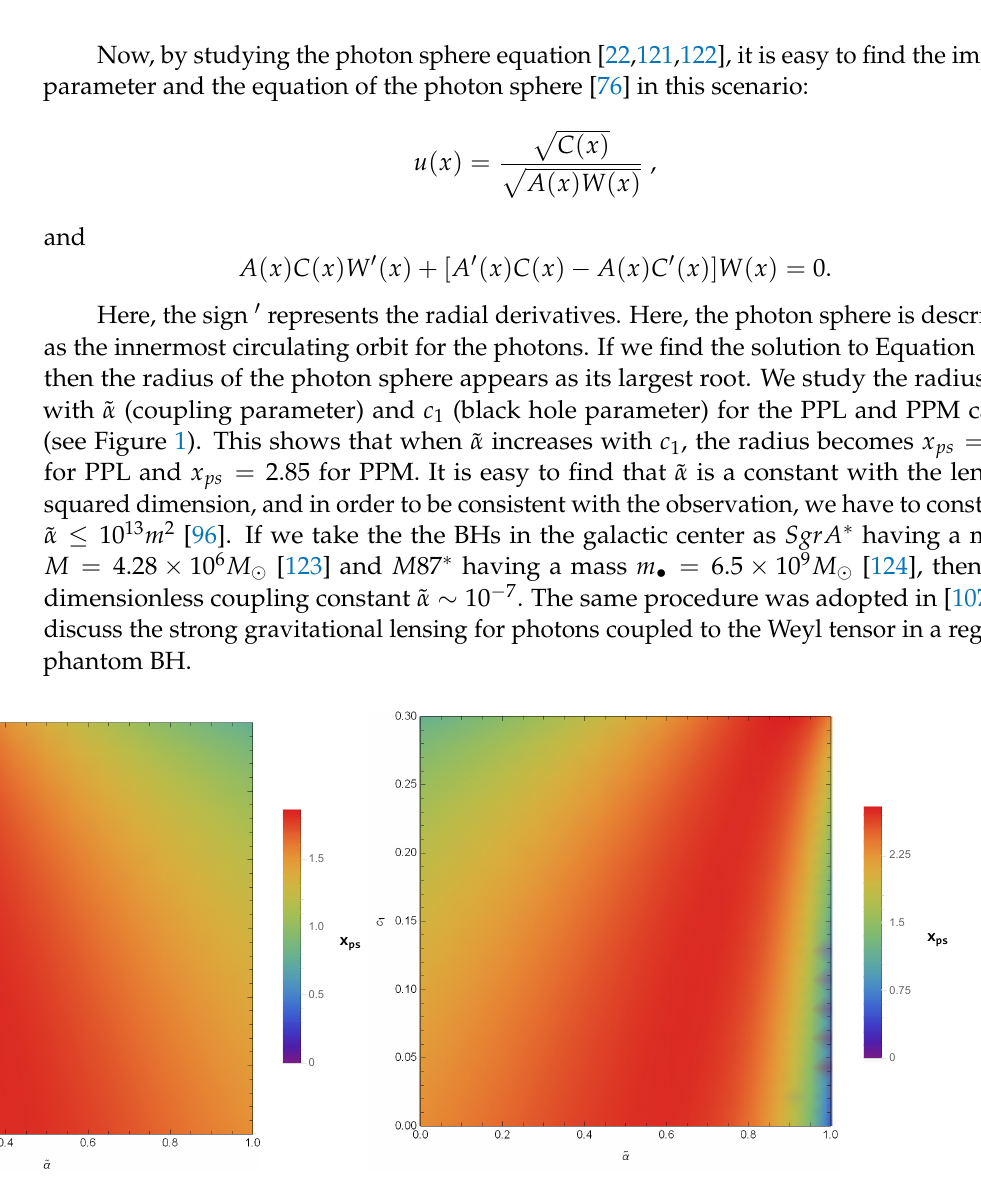
Figure 1. Color-indexed variations of the radius ( x ps ) with ˜ α and c 1 ( left ) for PPL and ( right ) for PPM. √ Here, we set c 0 = 3 c 1 d + 1, d = 1, and Λ = −